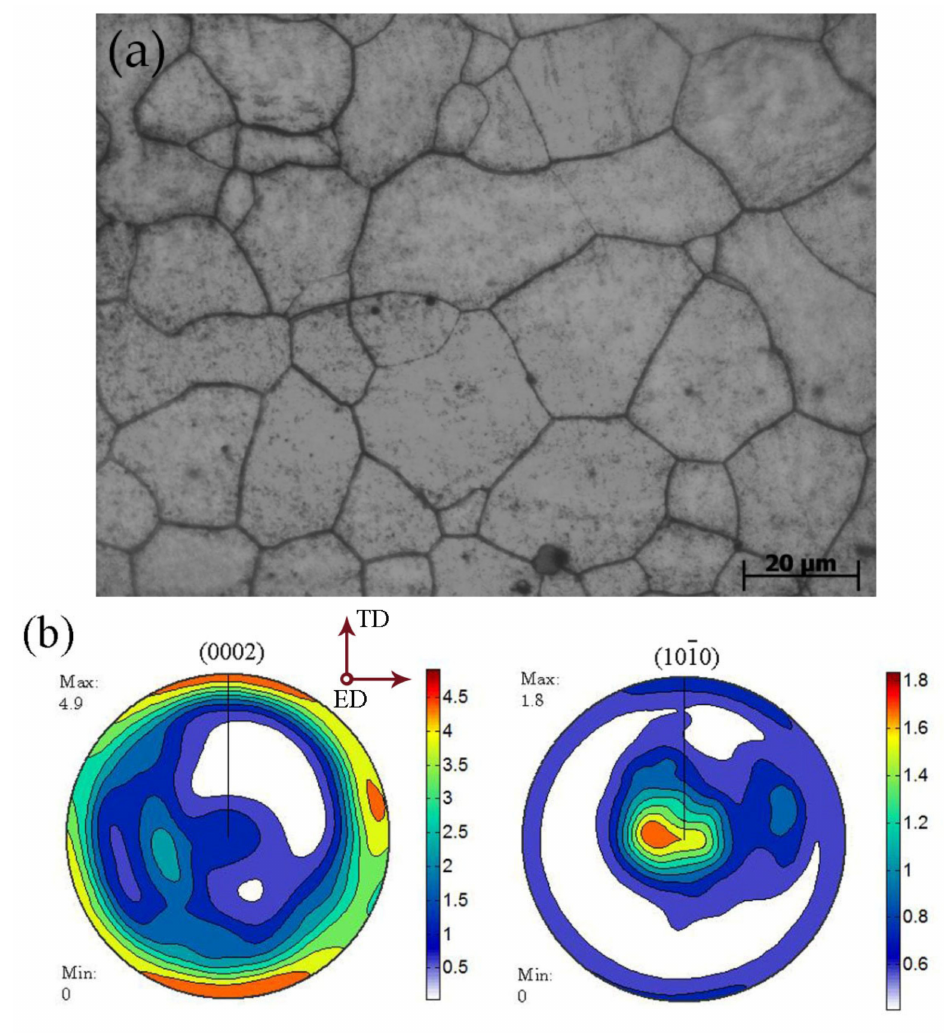
− 10} pole figures of the as-received